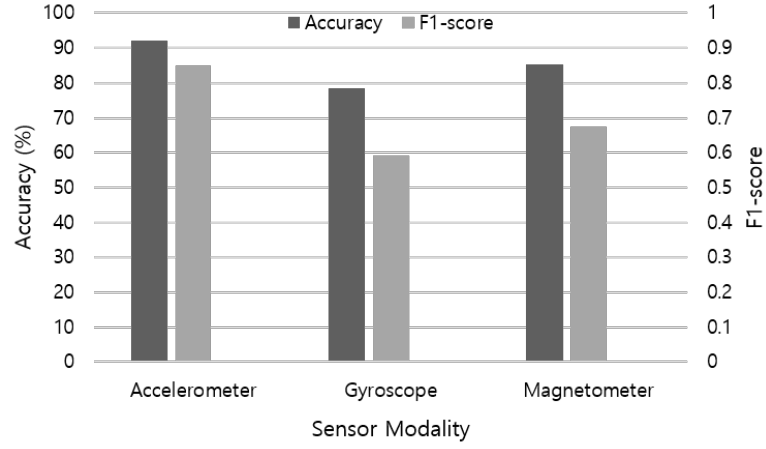
Figure 9. Recognition accuracy and F1-score measure of each sensor modality using the LSTM